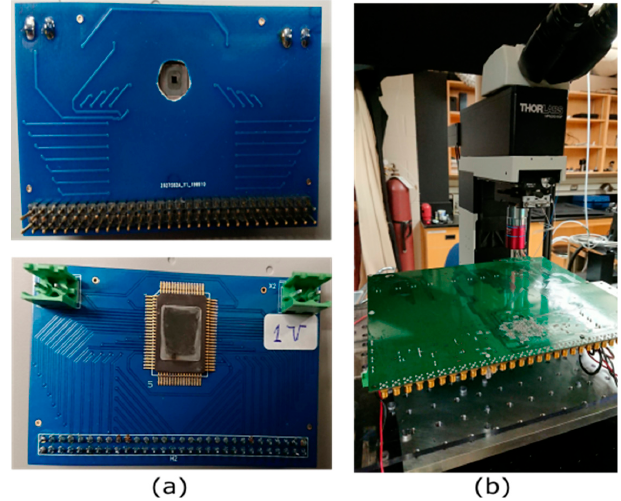
Figure 18. ( a ) Top & bottom sides of SRAM chip; ( b ) testing system profile.